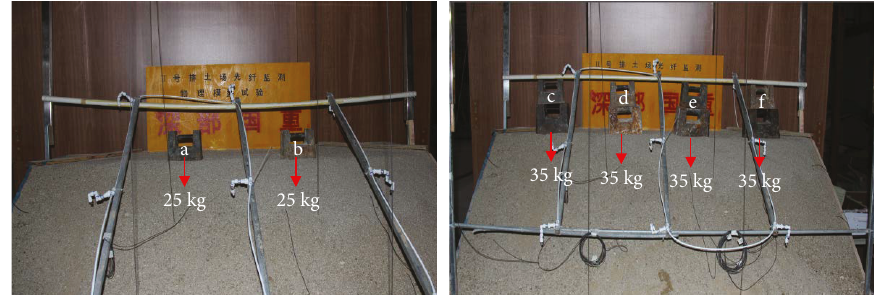
Figure 7: Fiber optic strain experiment under di ff erent loading